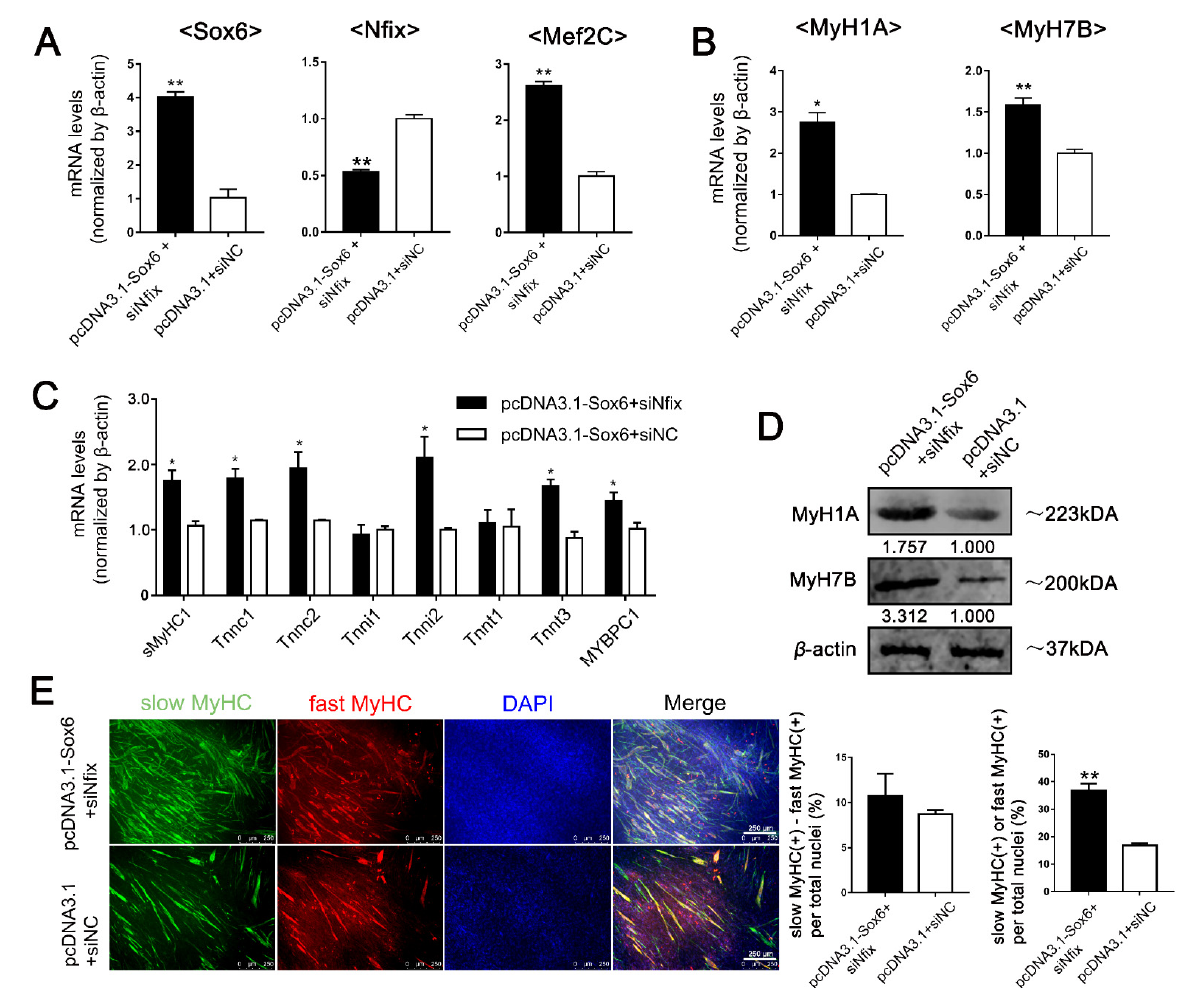
Figure 6. Overexpression of Sox6 in Nfix -inhibited PM-MTs promotes the expression of Mef2C and slow-type fibers. ( A ) After inducing differentiation for 3 days, the relative expression levels of Sox6 , Nfix and Mef2C in Sox6 -overexpressing PM-MTs with Nfix inhibition were quantified by qPCR (mean ± SEM; ** p < 0.01; n = 3; two-tailed Student’s t -test). ( B ) After inducing differentiation for 3 days, the relative expression levels of MyH1A and MyH7B in Sox6 -overexpressing PM-MTs with Nfix inhibition were quantified by qPCR (mean ± SEM; * p < 0.05; ** p < 0.01; n = 3; two-tailed Student’s t -test). ( C ) After inducing differentiation for 3 days, the relative expression levels of fast- and slow-type fiber isoforms in Sox6 -overexpressing PM-MTs with Nfix inhibition were quantified by qPCR (mean ± SEM; * p < 0.05; n = 3; two-tailed Student’s t -test). ( D ) Western blot on lysates from Sox6 -overexpressing PM-MTs with Nfix inhibition and control group myotubes after inducing differentiation for 3 days. β -actin was used to normalize. ( E ) After inducing differentiation for 3 days, myotubes derived from Sox6 -overexpressing PM-MTs with Nfix inhibition were performing immunofluorescence double staining against S58 (slow-type MyHC, green) and F59 (fast-type MyHC, red) and nuclei were counterstained with DAPI. The slow MyHC(+) nuclei or fast MyHC(+) nuclei were counted. The proportion of slow MyHC(+) cells − fast MyHC(+) cells among total nuclei and the proportion of cells in slow MyHC(+) myotubes or fast MyHC(+) myotubes among total nuclei are presented as mean ± SEM (** p < 0.01; n = 3; two-tailed Student’s t -test).